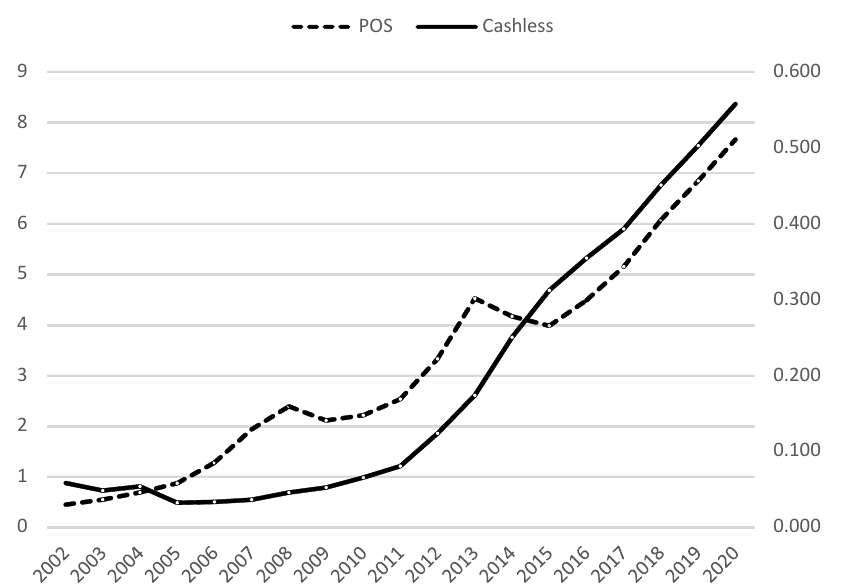
Figure 3. Comparison of the dynamics of changes in the payment infrastructure parameters and the share of cashless payment